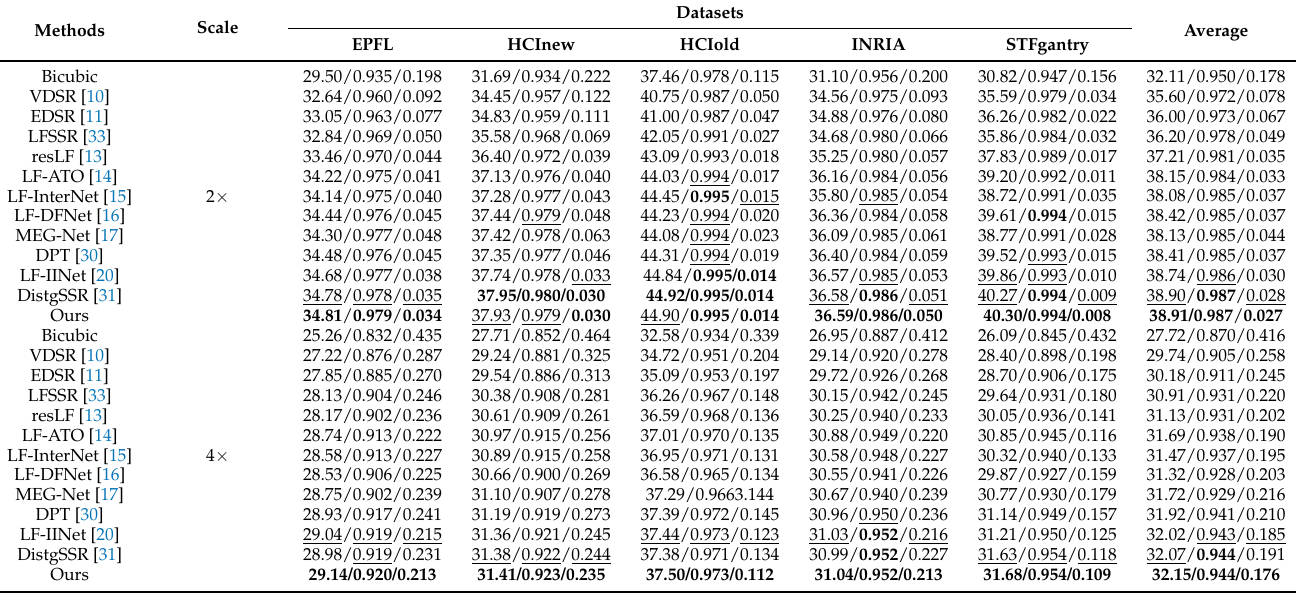
Table 2. PSNR/SSIM/LPIPS values achieved by different methods for 2 × and 4 × SR, the best results are in bold and the second best results are